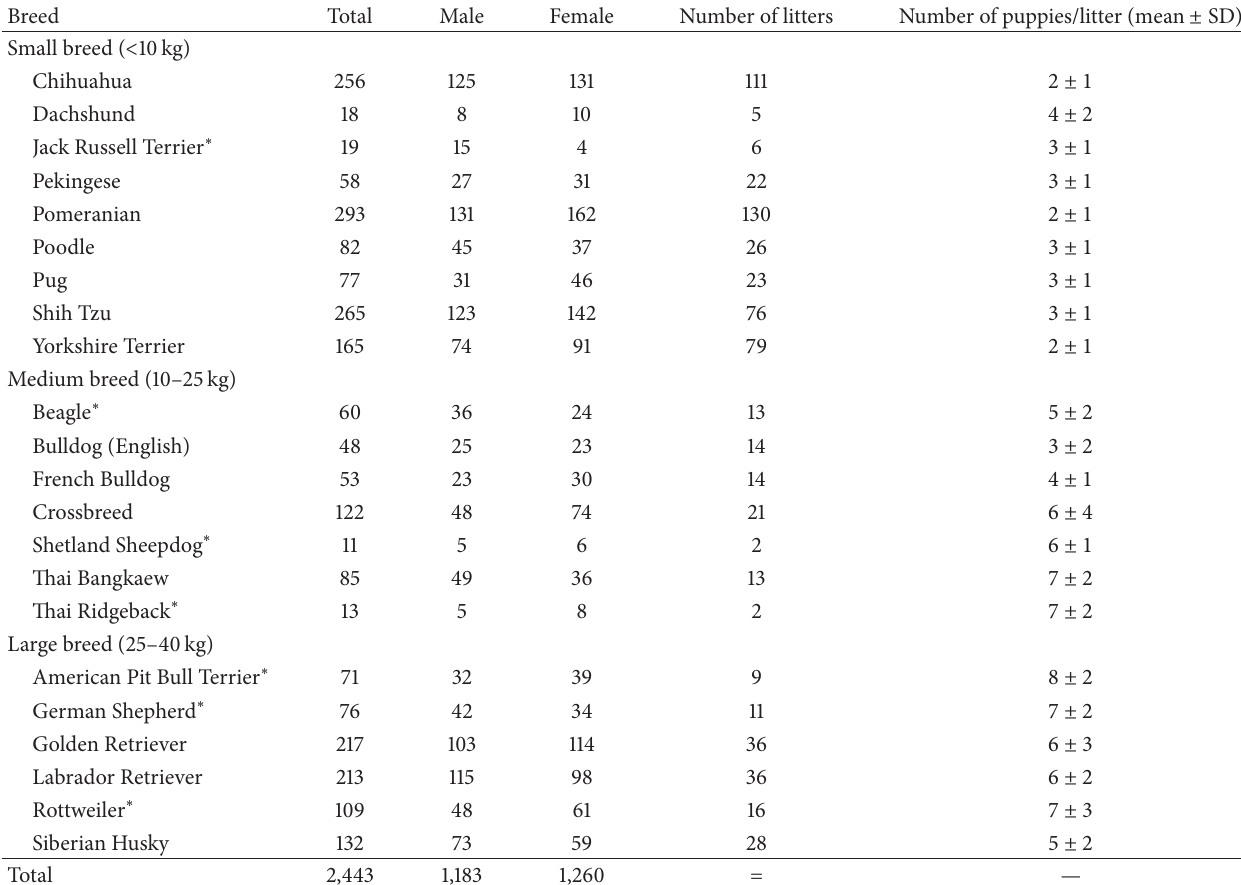
Table 1: Number of puppies in each breed included in the